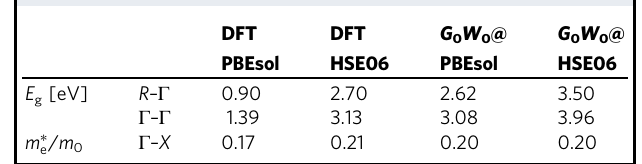
Table 1 Band gaps, E g , and effective electron masses, m (cid:1) m 0 , of cubic BaSnO 3 , obtained by PBEsol, HSE06,